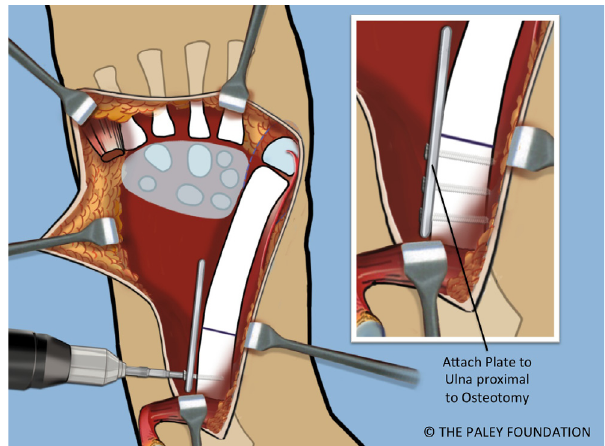
Figure 13. The ulnar diaphysis is exposed by elevating the FCU proximally. The level of the planned osteotomy is marked.